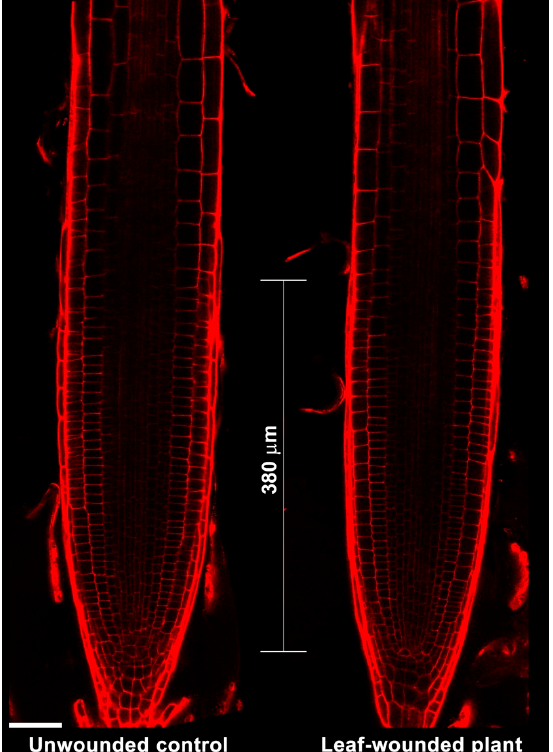
Figure 3. Analysis under LSCM after PI staining of the leaf wounding effect on the length of the meristematic zone, determined by measuring the distance between the quiescent centre and the first elongating cell in the cortex cell file. The images presented show roots from 10-day-old unwounded control and leaf-wounded seedlings, injured at the age of 7 days by cutting the cotyledonary leaf with scissors and analysed 3 days after the injury; roots presented are representative of experiments repeated at least five times with ten seedlings analysed each time. Shown images were obtained aligning serial overlapping micrographs of the same root by Photoshop Software (Adobe). Bar: 50 µ